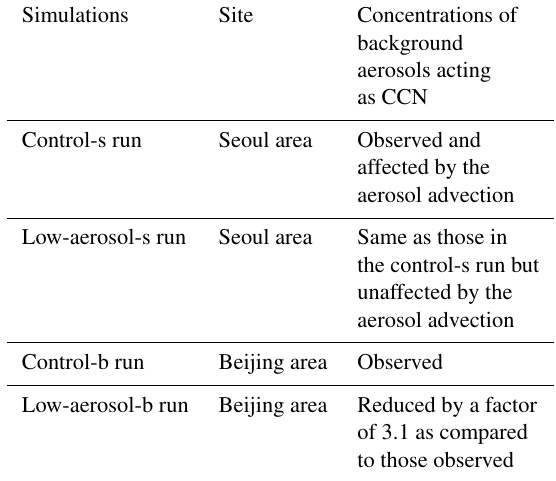
Table 1. Summary of